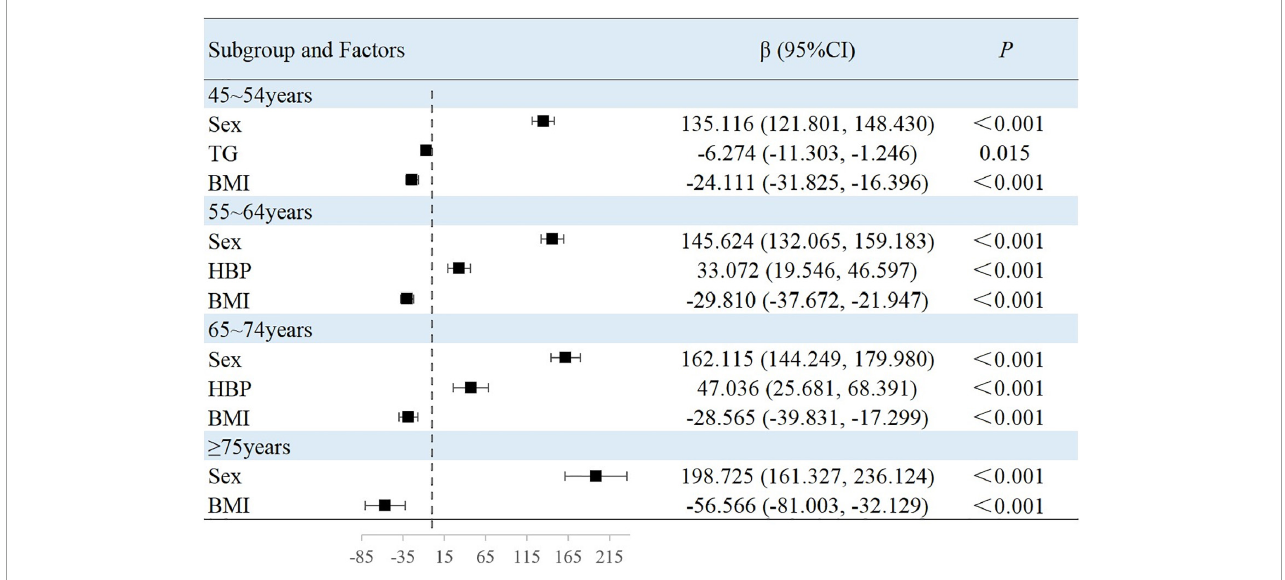
FIGURE6 Factors associated with BAR in subgroup analysis by age.